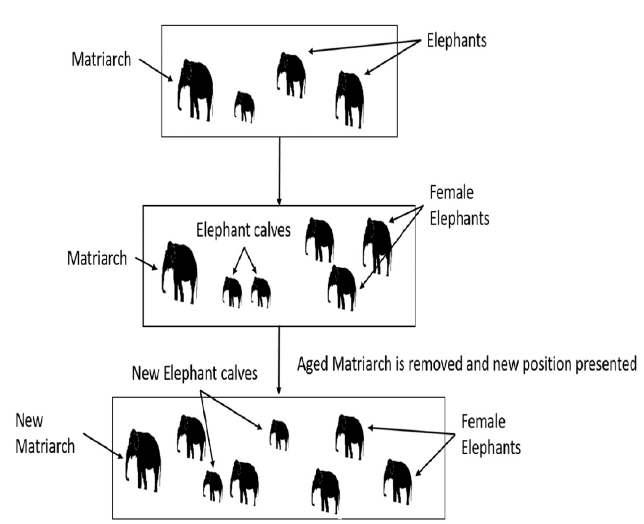
Figure 1. Elephant behaviour in a clan.